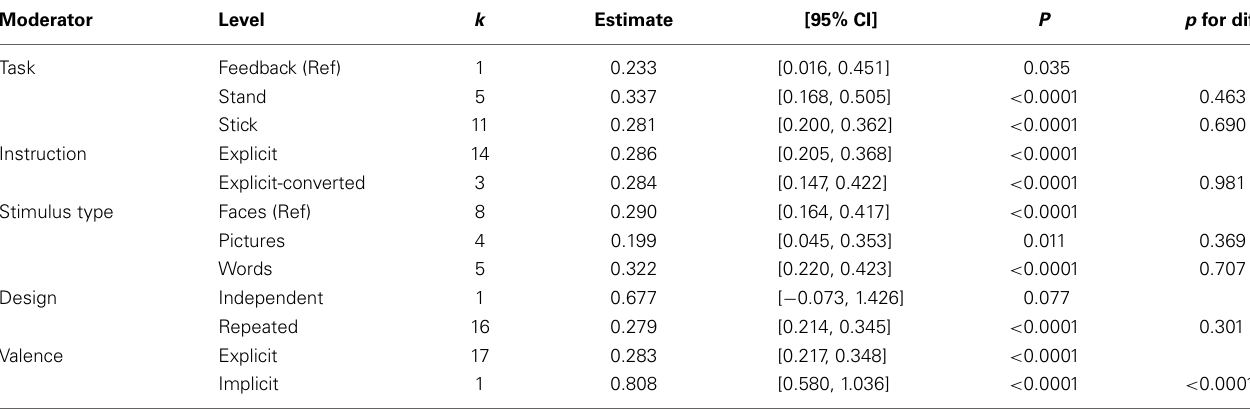
Table 2 | Results of subset analyses of positive affect after exclusion of studies with implicit